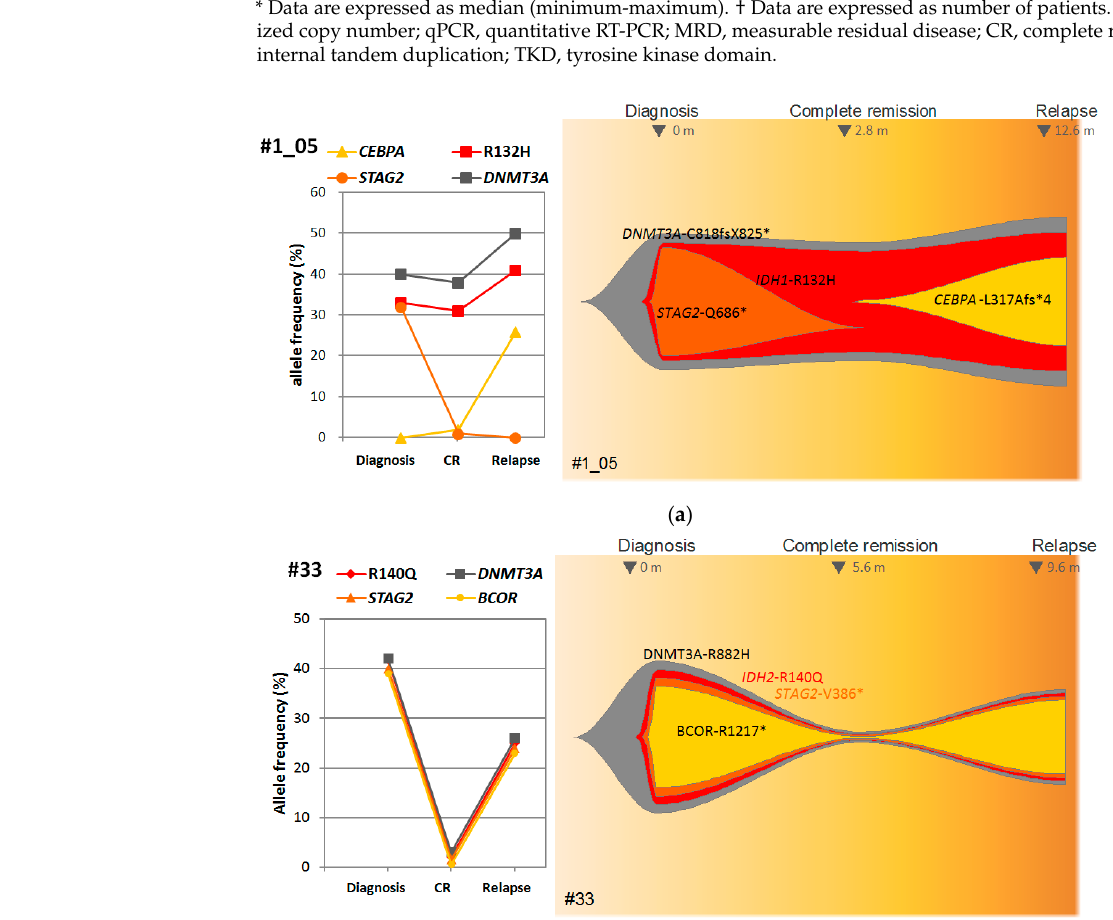
Table 3. Clinical characteristics and the correlation between IDH1/2 qPCR MRD and hematologic remission status.